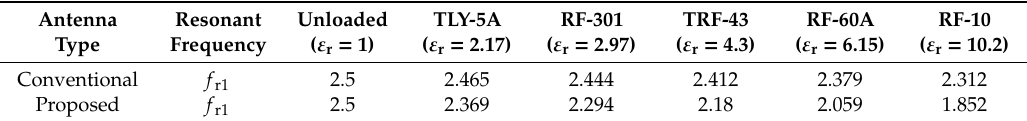
Figure 12. Simulated sensitivity comparison of the conventional and proposed patch antennas for the MUTs in Table 2: ( a ) Δ f r ; ( b ) PRFS; ( c ) PRFSE; ( d ) S; ( e ) SE. Table 3. Simulated first resonant frequencies for S 11 responses in the conventional and proposed patch antennas in GHz.